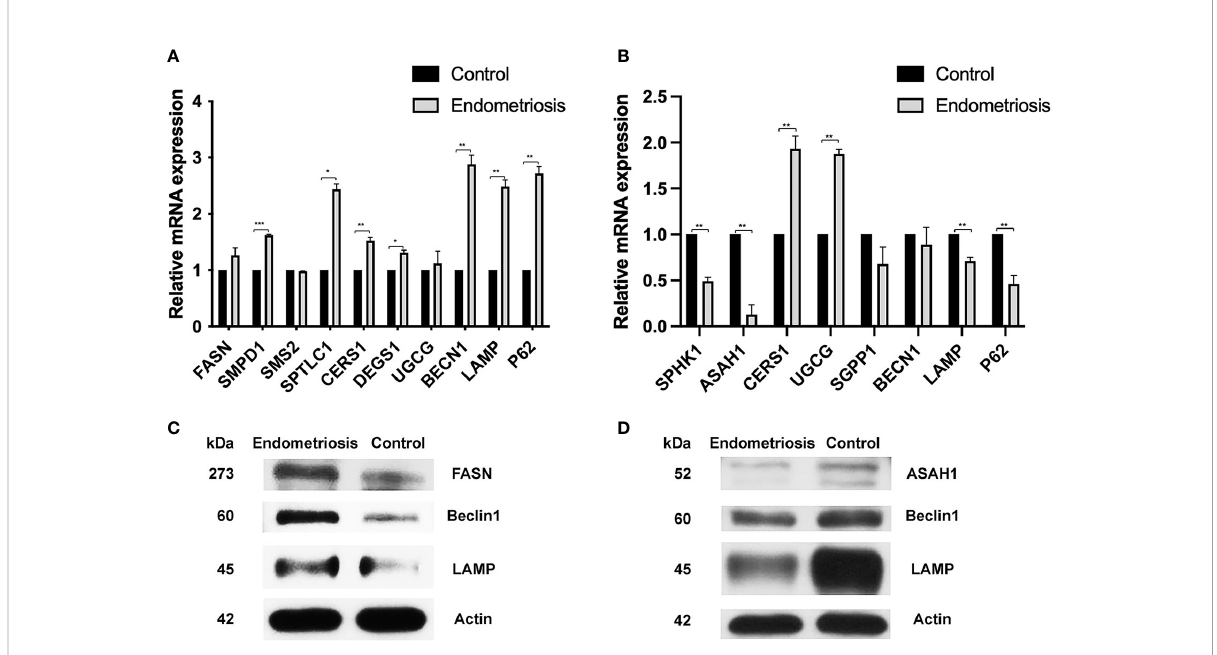
FIGURE 4 qRT-PCR expression analysis and protein expression of the ceramide synthesis and the autophagic pathway in CCs and MGCs compared between normal and endometriosis patients. (A) The expression levels of a gene involved in ceramide synthesis (CERS1, SPTL1, SMPD1, SMPD2, and SMPD3) and genes involved in autophagy (BECN1, LAMP, and P62) were analyzed in CCs compared between normal and endometriosis patients. (B) The expression levels of a gene involved in ceramide synthesis (SPHK1, ASAH1, CERS1, UGCG, and SGPP1) and genes involved in autophagy (BECN1, LAMP, and P62) were analyzed in MGCs compared between normal and endometriosis patients. Data (technical triplicates of three biological experiments) are reported as means ± standard error. *, **, *** indicate a statistically signi fi cant difference (p< 0.05, 0.01 and 0.001 respectively). Protein expression in CCs (C) and MGCs (D) was determined by Western blotting using antibodies against FASN, ASAH1, Beclin1, LAMP, and Actin. The actin band indicates equal loading of proteins. CCs, cumulus cells; MGCs, mural granulosa